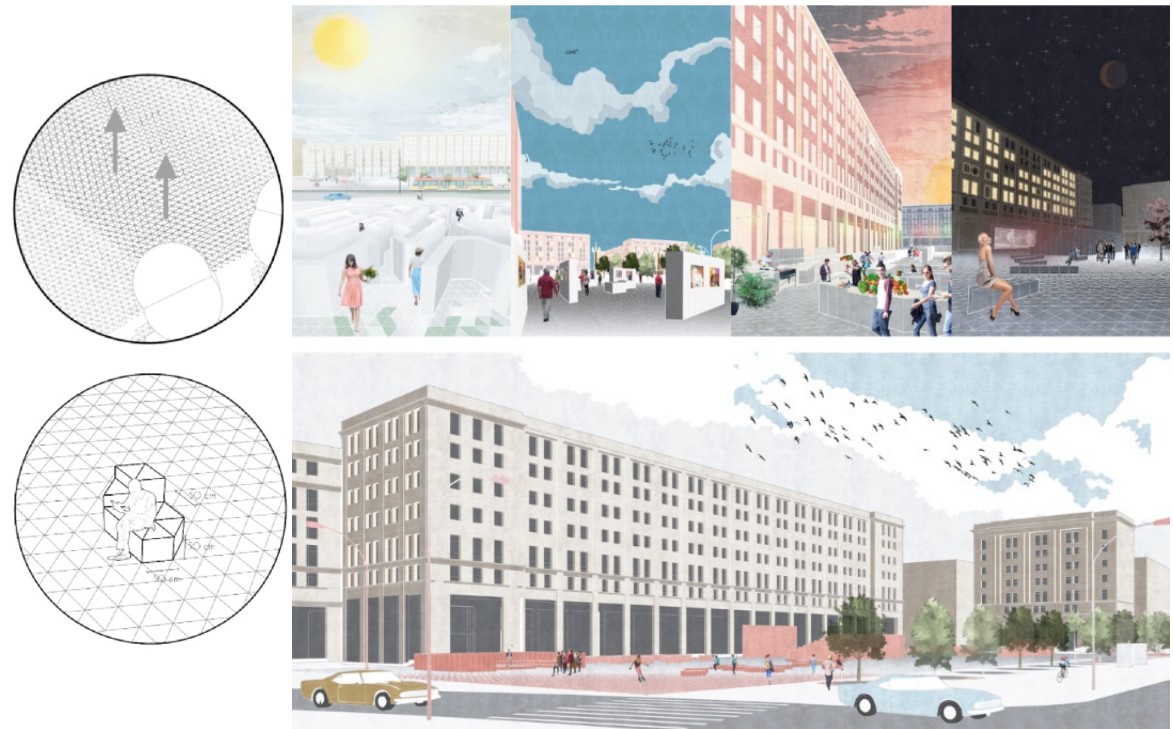
Figure 9. ( Left ): Diagram illustrating how the square’s surface is shaped by the network of triangular modules, moving vertically. ( Right ): Various examples of repurposing the space using the modular floor system.